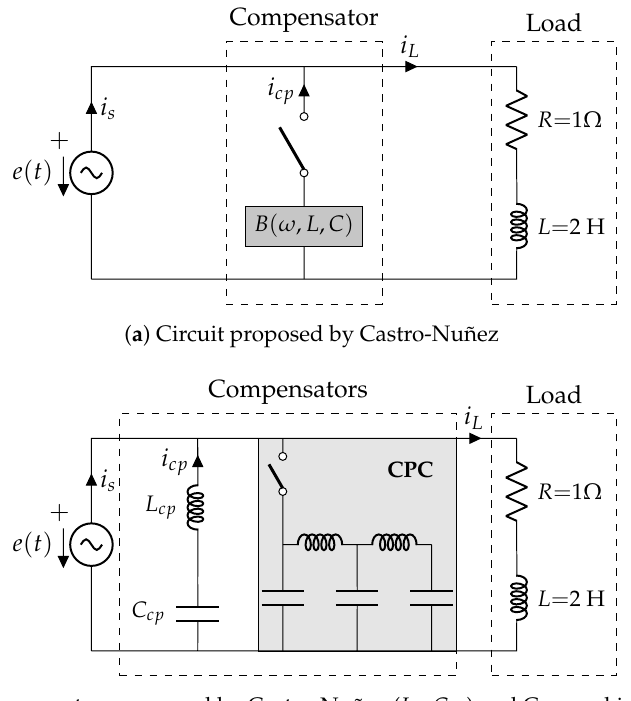
Figure 6. Circuit with distorted voltage source and a linear load used by Castro-Nuñez and Castro-Puche